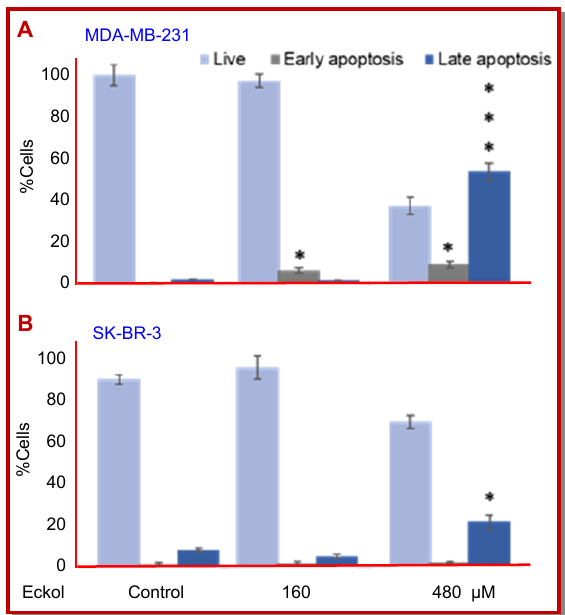
Figure 4: Eckol treatment caused apoptotic cell death in MDA- MB-231 and SK-BR-3 cell lines. A) The apoptotic cell rate was analyzed in MDA-MB-231 cells after incubation with eckol at increasing concentrations (C, 160, and 480 µM) for 2 hours B) SK-BR-3 cells treated with C, 160, and 480 µM eckol concentra- tions for 2 hours. Apoptotic cell rate was analyzed by flow cytometry. a indicates p < 0.05 , b p < 0.01 , c p < 0.001